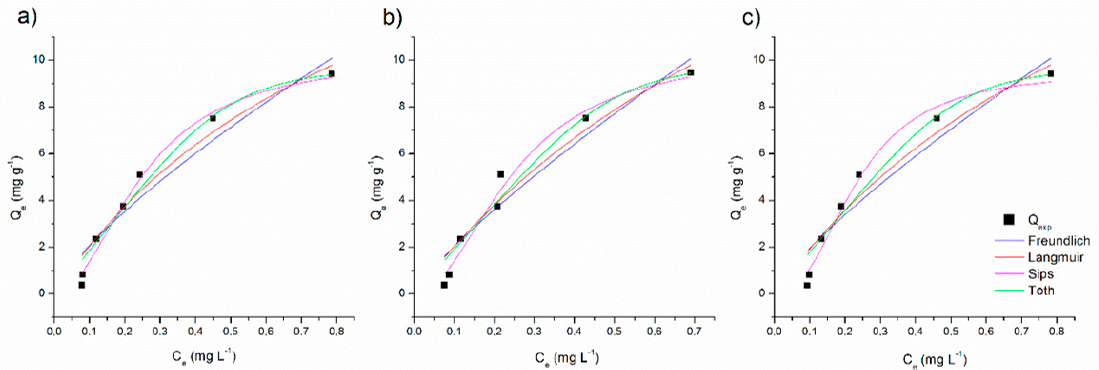
Figure 6. Fitting data for adsorption isotherms models for ( a ) 15 °C, ( b ) 30 °C, and ( c ) 45 °C (methylene blue (MB) concentration = 1.0–20.0 mg L − 1 , adsorbent concentration = 2.0 g L − 1 , particle size = 30 mesh, sample volume = 50 mL, contact time = 24 h, stirring speed = 150 rpm).